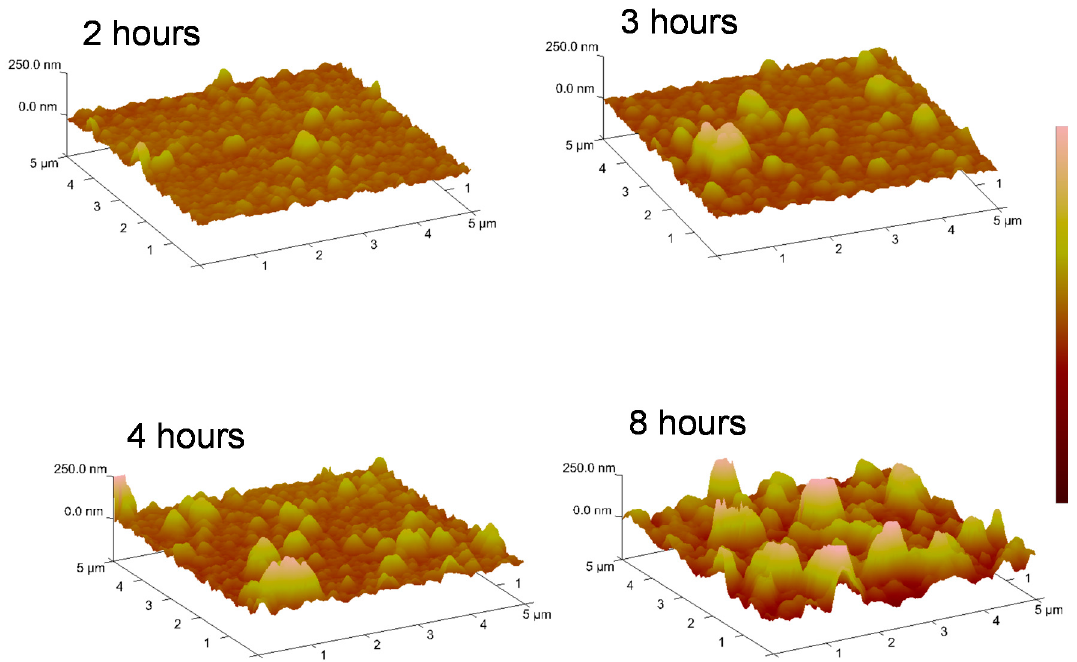
Figure 4. AFM images of surface topography after different polymerization